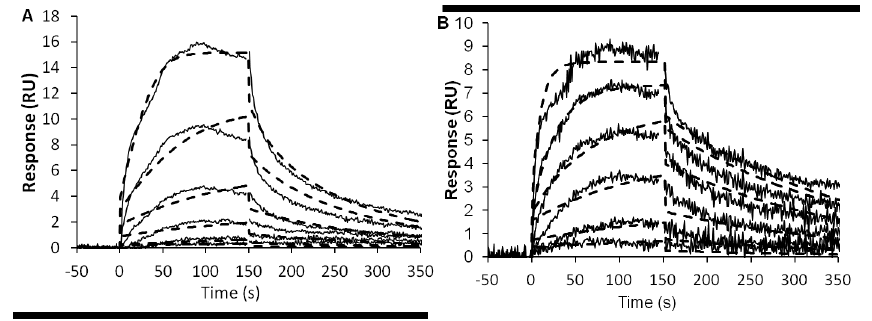
Figure 2. Kinetic analyses of BMP-2 binding to (A) dermatan sulfate (DS) and (B) heparin (HP). Solid lines represent the binding curves for six BMP-2 concentrations ranging from 0.2 to 50 nM. The dotted lines depict the result of a global fit of a 1:1 interaction model to the binding data. The binding affinity, K constants, k /k . The study yielded an affinity constant, K d a x10 -9 M for the binding to HP. The standard deviation is based on the variation between duplicate experiments. doi: